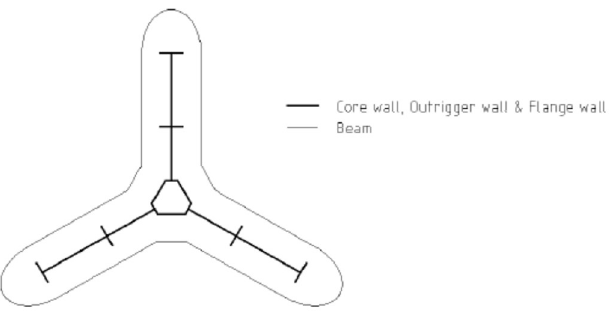
Figure 5. Cross section of buttressed core system. Source: [12].